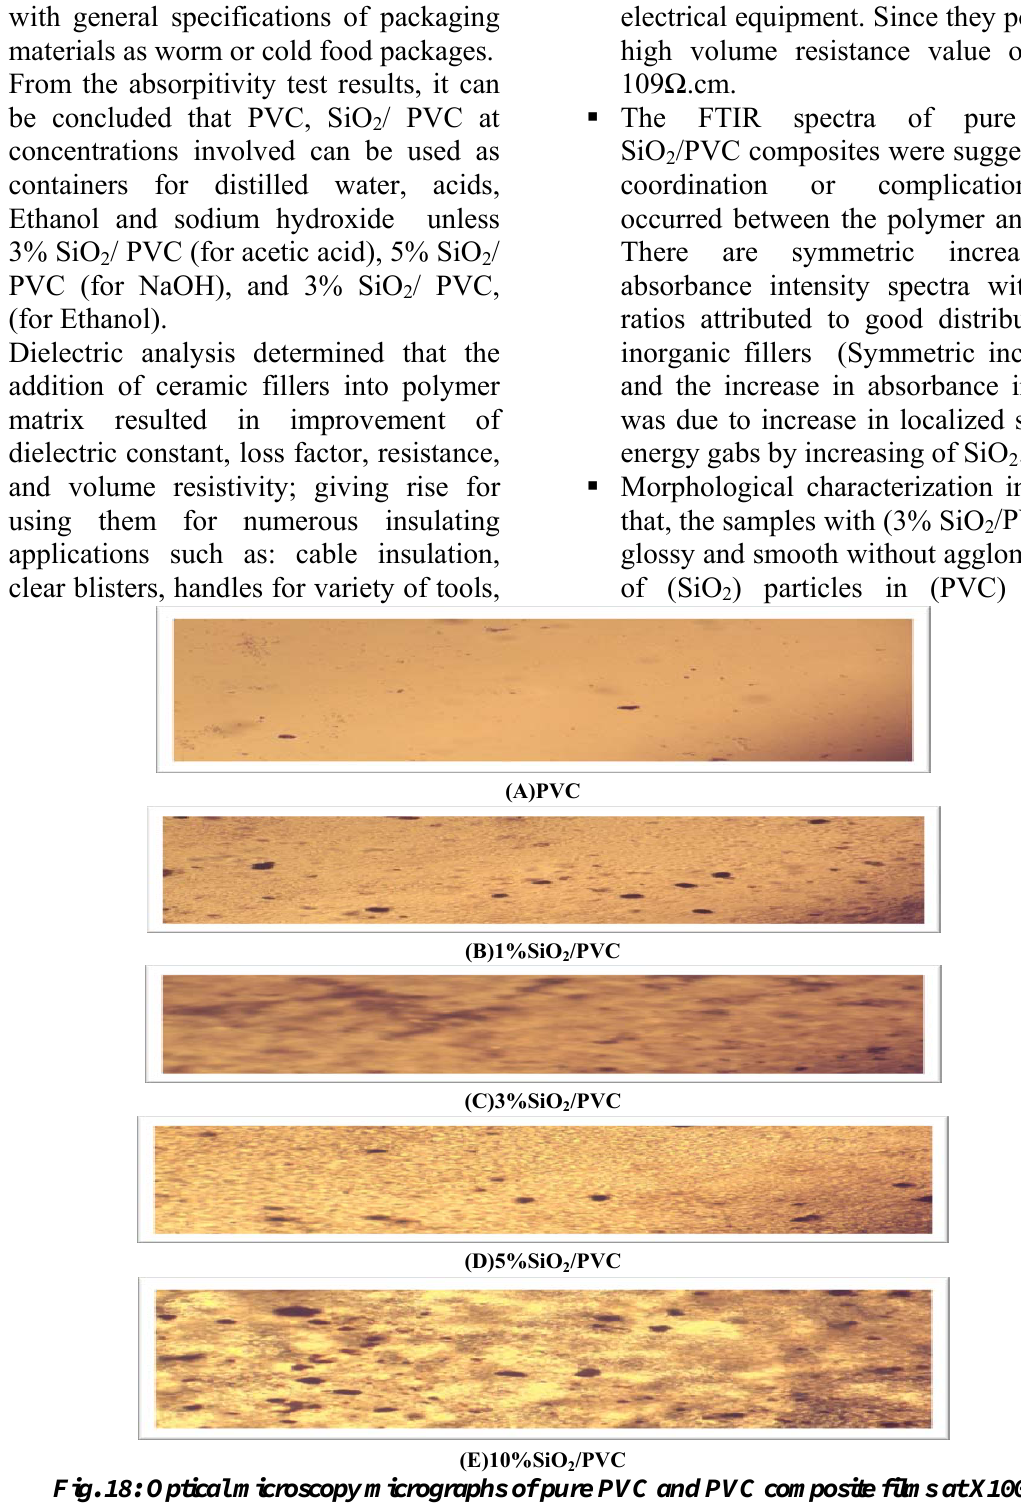
Fig. 18: Optical microscopy micrographs of pure PVC and PVC composite films at